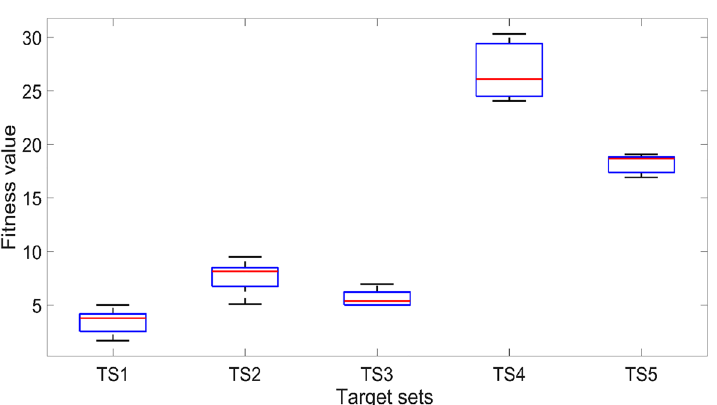
Figure 11. Comparison of fitness values with the 20 voxel single symmetric void model for target deflection sets TS 1 to TS5. Each box plot represents the results of 5 trials for each target set. The lower the fitness value, the closer the obtained deflection sets to the target deflection sets. The solid lines in the middle indicate the median fitness values, the top and bottom of the boxes represent the 25th and 75th